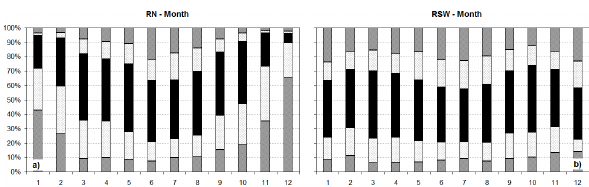
Figure 6. Monthly variability of the accuracy of EF upscaling meth- ods using different components of available energy. RN method (a) neglects daytime G 0 , while RSW method (b) uses shortwave net radiation only. See caption of Fig. 5 for the description of the color